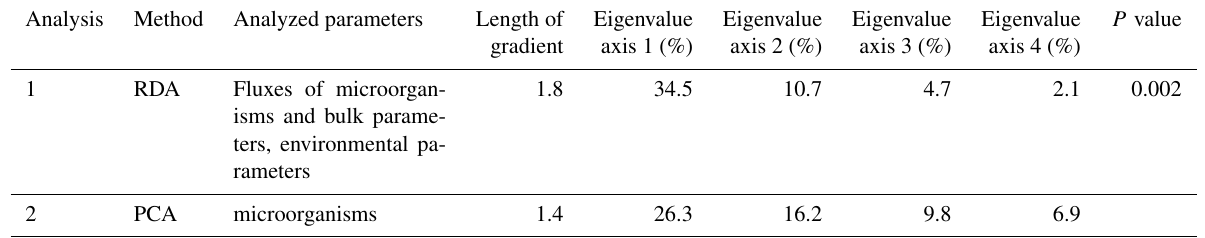
Table 2. Main result values of the ordination techniques redundancy (RDA) and principal component (PCA) analyses performed with the software package Canoco 5 (ter Braak and Smilauer, 2012; Smilauer and Leps, 2014).